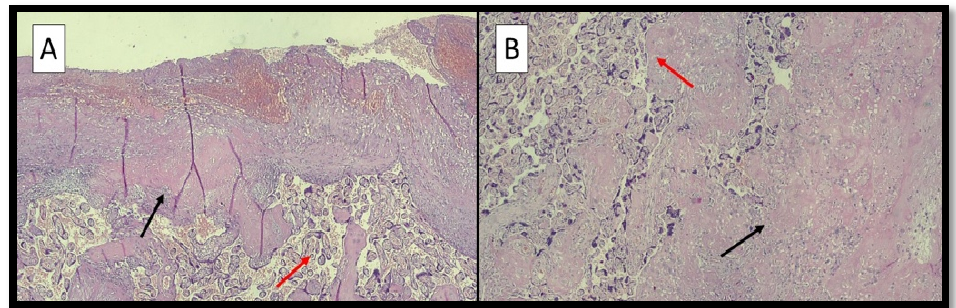
Figure 1. ( A ) Photomicrograph showing peculiar histopathological features associated with hypoxic conditions: villous hypermaturity (red arrow) and Laminar Necrosis (LN) foci (black arrow) (hematoxylin-eosin; original magnification, 4x). ( B ) Photomicrograph showing distal villous hypoplasia (red arrow) and LN foci (black arrow) (hematoxylin-eosin; original magnification, 10x).